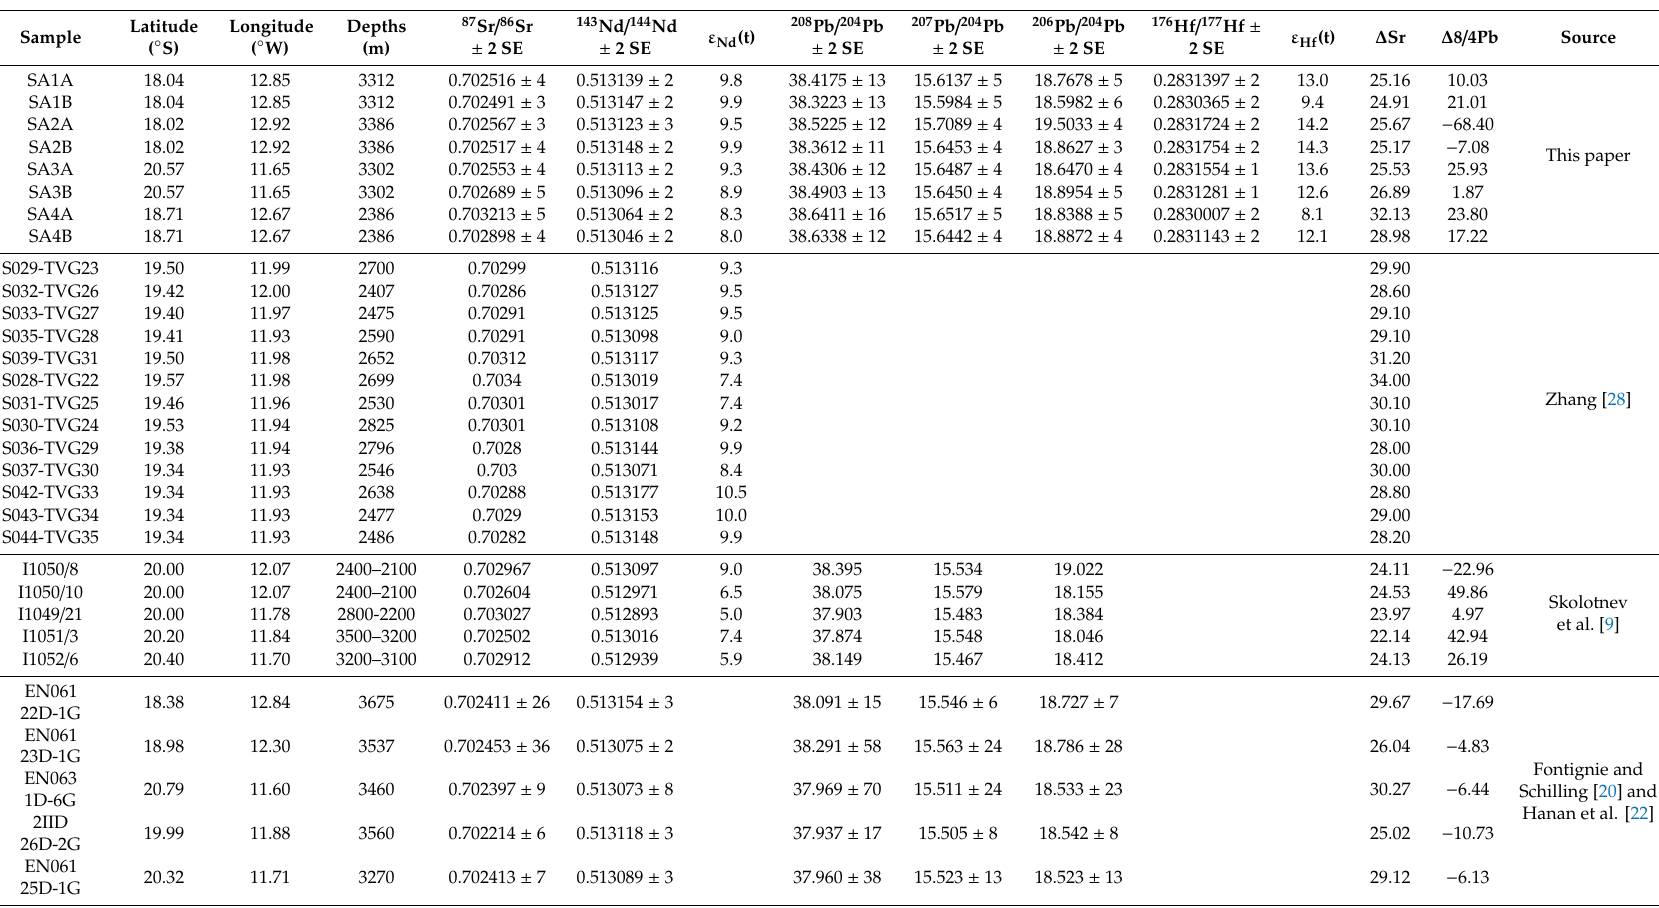
Table 1. Sr, Nd, Pb, and Hf isotope ratios in dredged basalts from the Southern Mid-Atlantic Ridge (18–21 ◦ S).